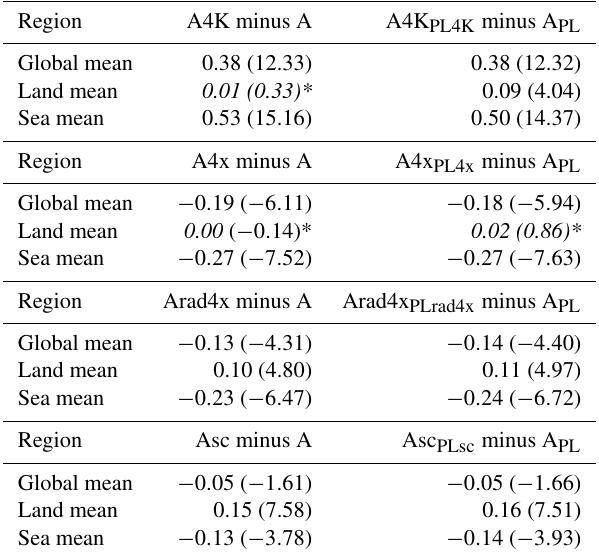
Table 4. The difference in global, land point and sea point mean precipitation, mmday − 1 (%) for each of the specified simulations in rows 1, 5, 9 and 13 (details of each simulation are given in Sect. 2). Numbers in italics and marked with an asterisk are not statistically significant using Student’s t test ( p > 0 .